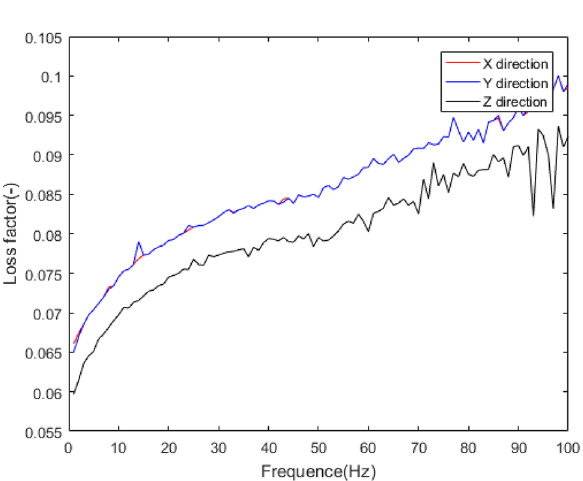
Figure 5. Relationship between translational loss factor in x/y/z direction and frequency.